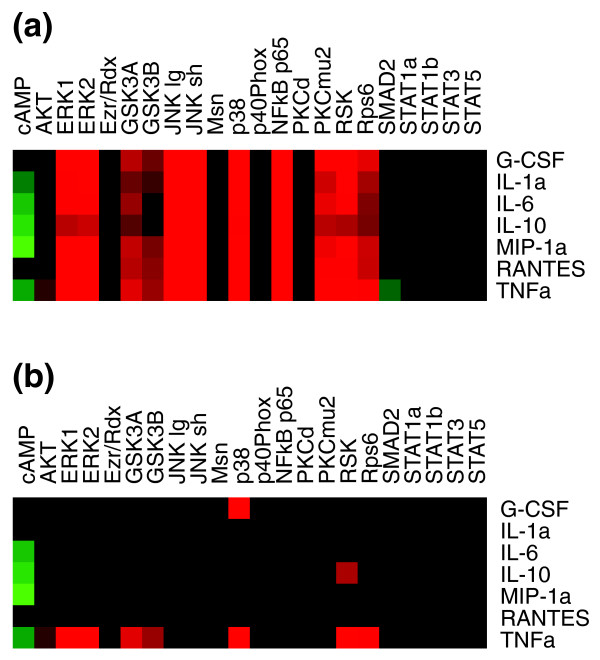
Correlation coefficients between signaling responses and cytokine release. Pearson's correlation coefficients were computed for each pair of signaling responses and cytokines using data from single- and double-ligand stimulations. Data from TLR ligand stimulation were (a) included in the procedure or (b) excluded from the procedure. Data were log-transformed and variance-normalized. Significance of correlations was assessed following a t distribution. Heat maps were produced from significant correlation coefficients (red = positive correlation; green = negative correlation).